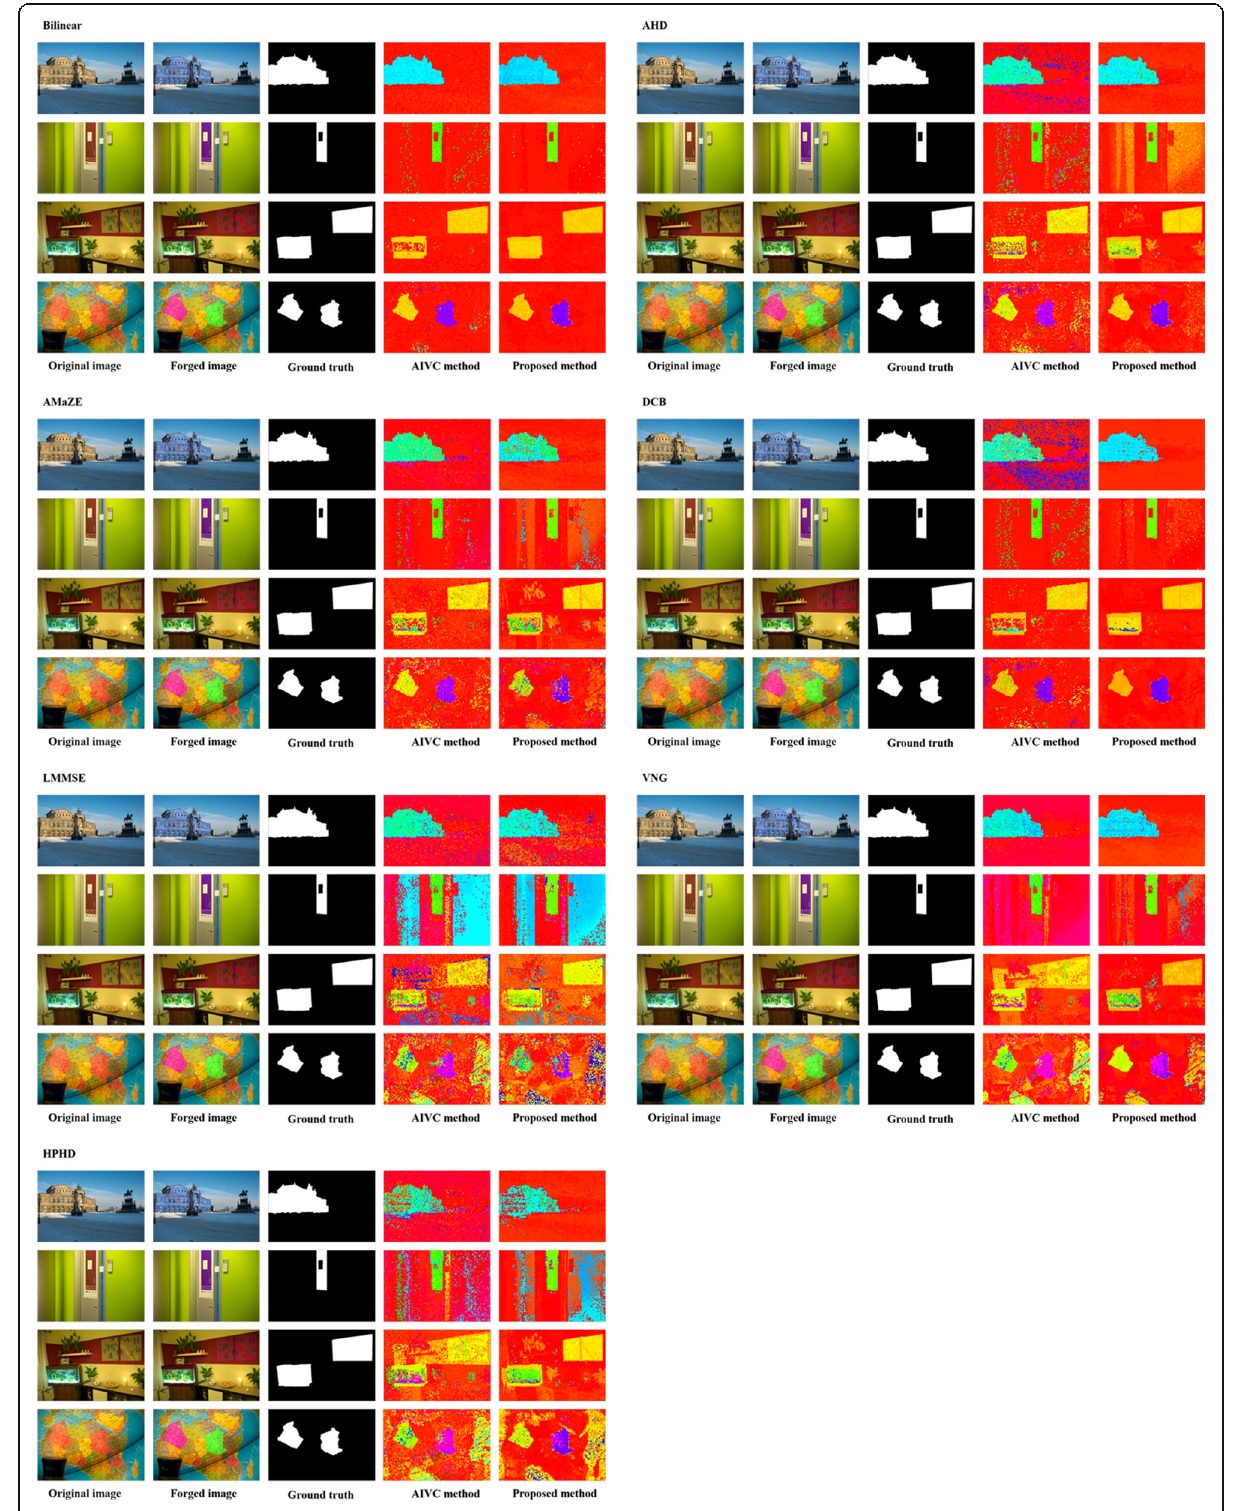
Fig. 7 Forged region detection results for various demosaicing